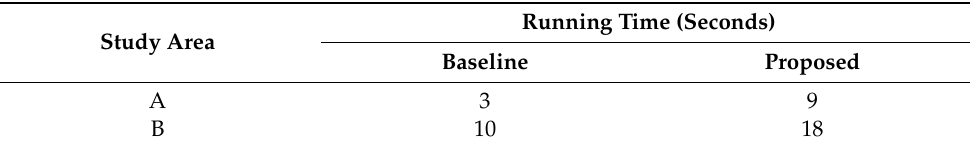
Table 4. Computational complexity analysis of the proposed